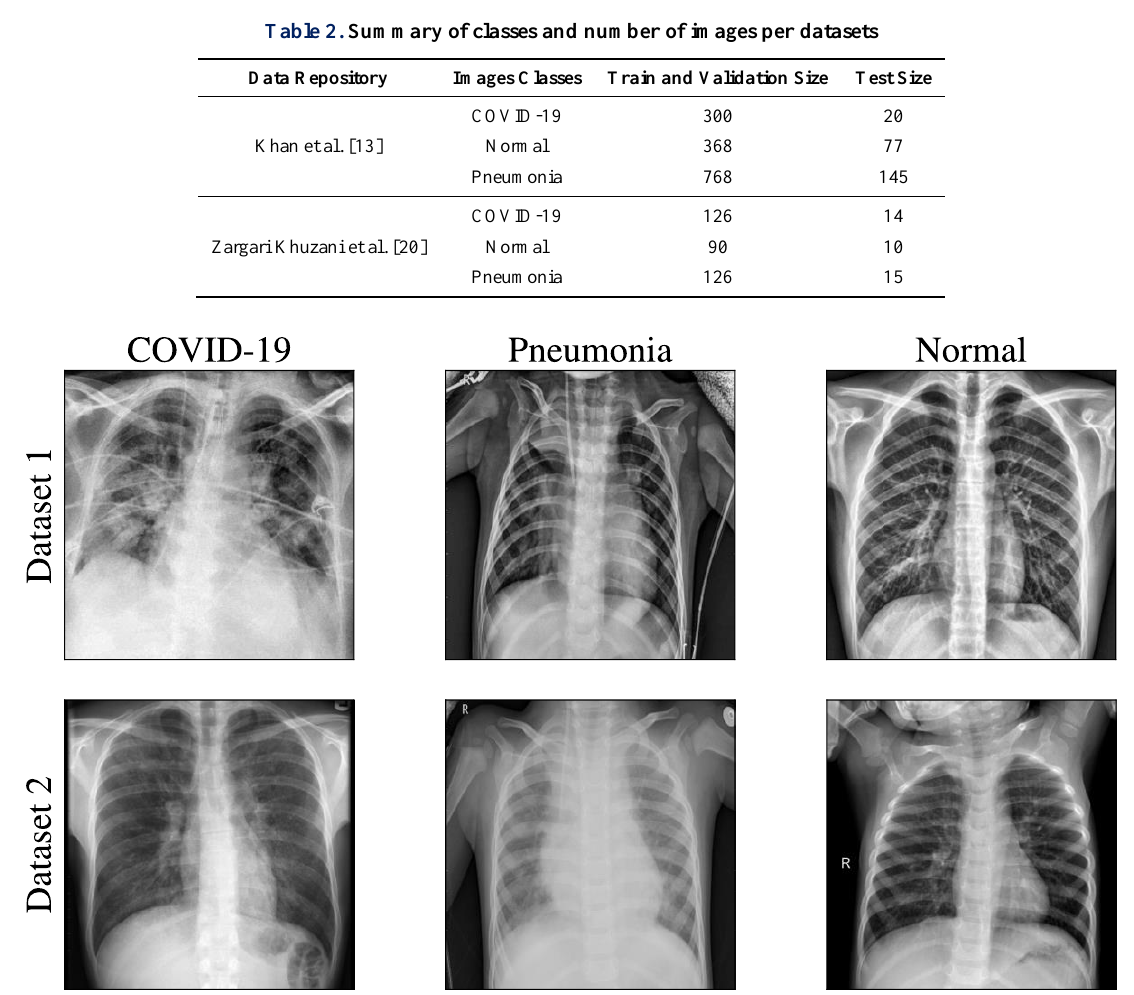
Figure 1. Randomly selected images from each dataset and